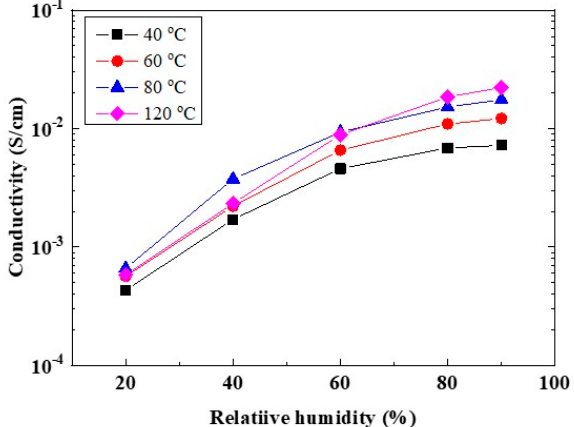
Figure 6. Proton conductivities of the CSPPSU membranes vs. the relative humidity at the specified temperatures.